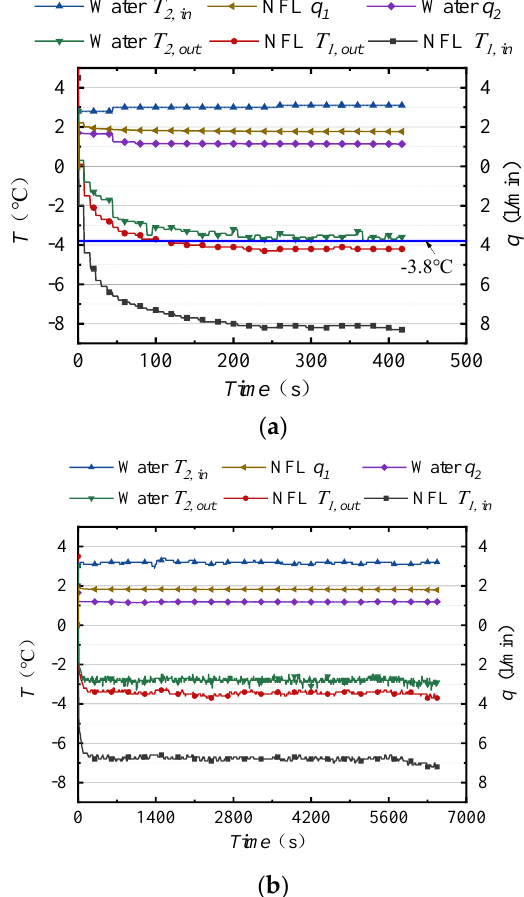
Figure 5. Maximum degree of subcooling and maximum duration t . ( a ) Subcooled water T 2, out : −3.8 °C. ( b ) Duration t : 108 min.